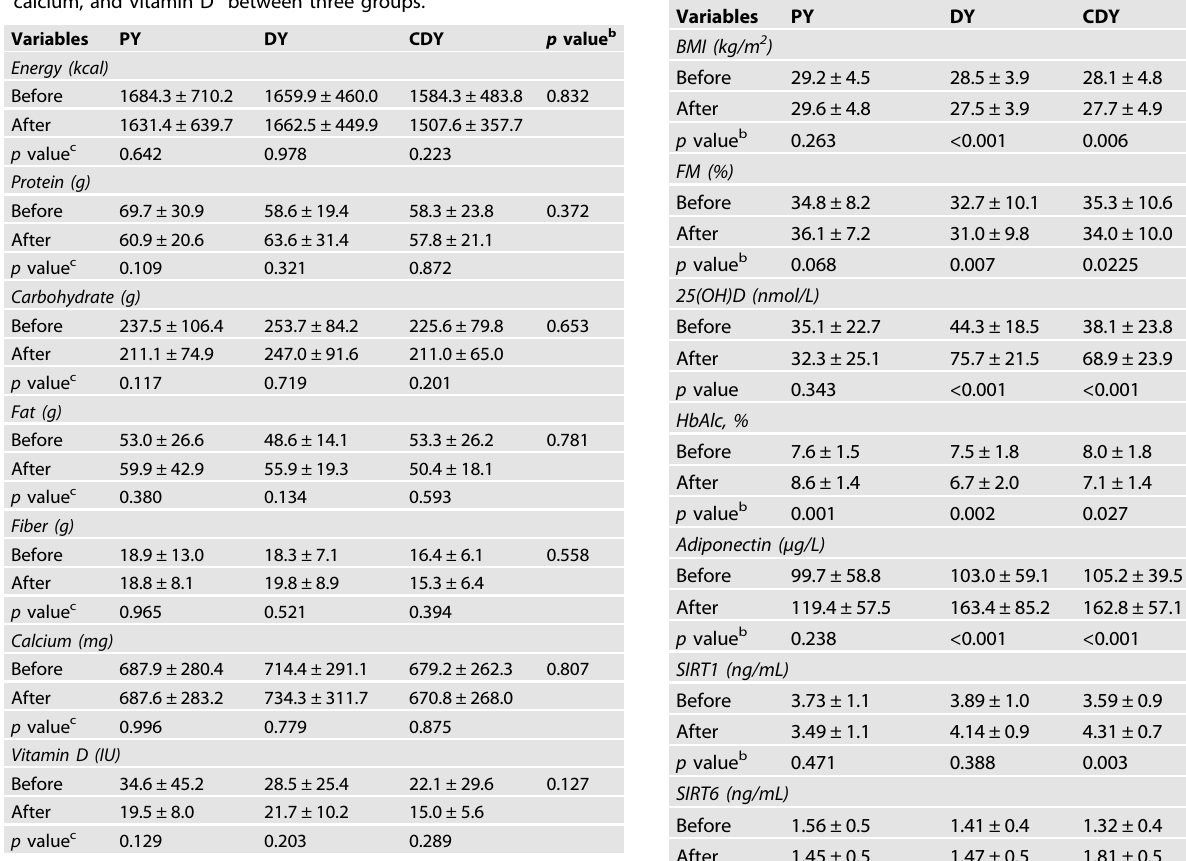
Table 2. Comparison of mean variables in groups over time. Table 1. Comparison of mean daily intake of energy, macronutrients,